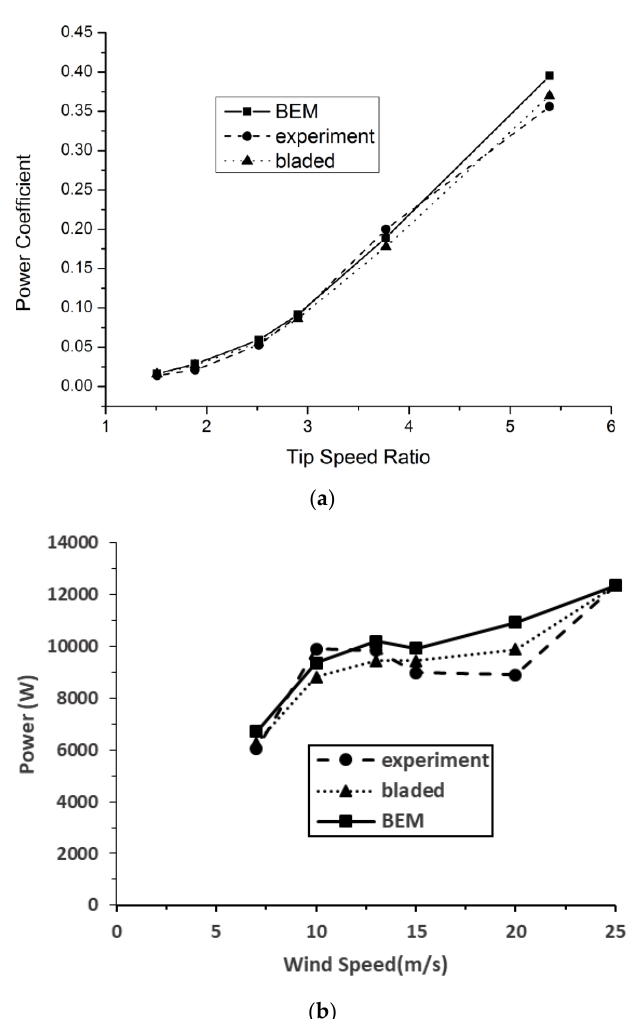
Figure 1. Aerodynamic performance of the NREL phase VI wind turbine from different methods: ( a ) Power coefficient changing with tip speed ratio; ( b ) power changing with wind speed. Note: “BEM” stands for the results obtained from the BEM procedure; “experiment” stands for the measurement results in ref [8]; “bladed” stands for the results by the use of GH Bladed software.